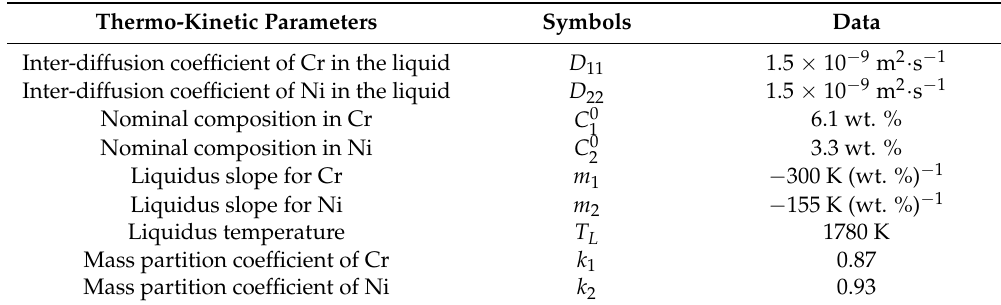
Table 5. Thermodynamic and kinetic parameters used for the application of the constitutional supercooling criterion in the case of an austenitic solidification of a ternary Fe-Cr-Ni alloy (1 = Cr, 2 = Ni). Ni and Cr concentrations are those measured by WDS (Figure 2b) on the intermediate plateau between 15 and 30 µ m from the fusion